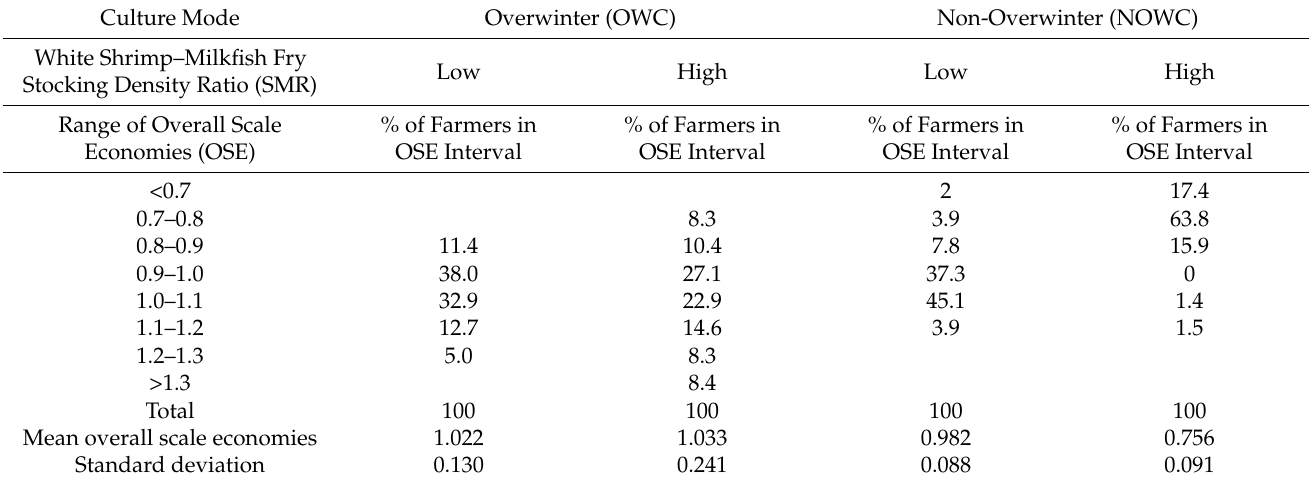
Table 4. Distribution of overall scale economies scores of low and high SMR in OWCs and